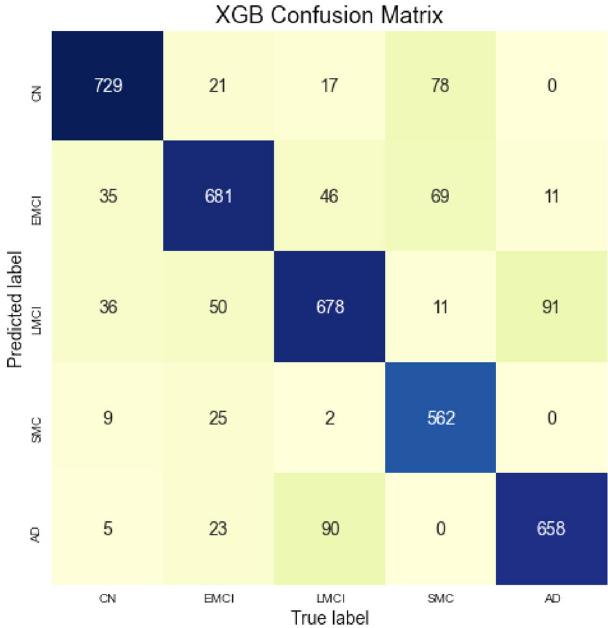
Figure 9. Confusion matrix for the XGBoost model.